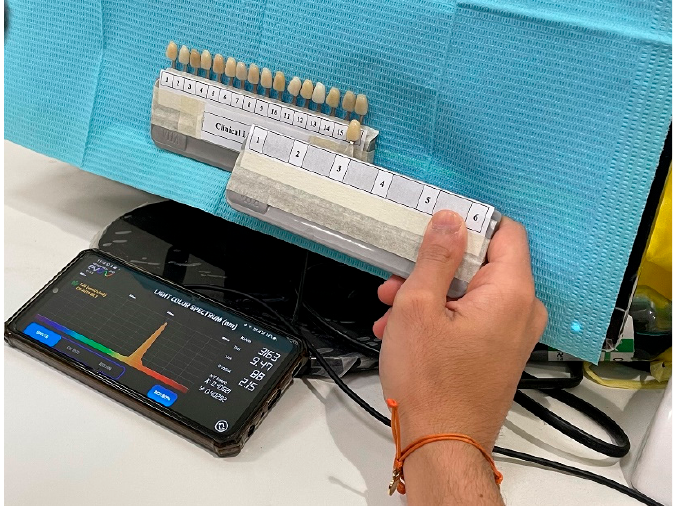
Figure 2. Dental operatory light (fluorescent light) with smartphone application Light Spectrum Pro EVO (AM Power Software, Via Località Passignano, 17 04025 Lenola (LT), Italia). A distance of 10 cm from the shade tab was maintained in shade-matching under the correcting light that was executed by the use of handheld Dental Base Light (Tri-Shade, Zhengzhou, Henan, China). The Dental Base Light comprises integrated 12 LED technology. The appropriate color temperature selected from correcting light was 5500°K for shade selection as shown in Figure 3.